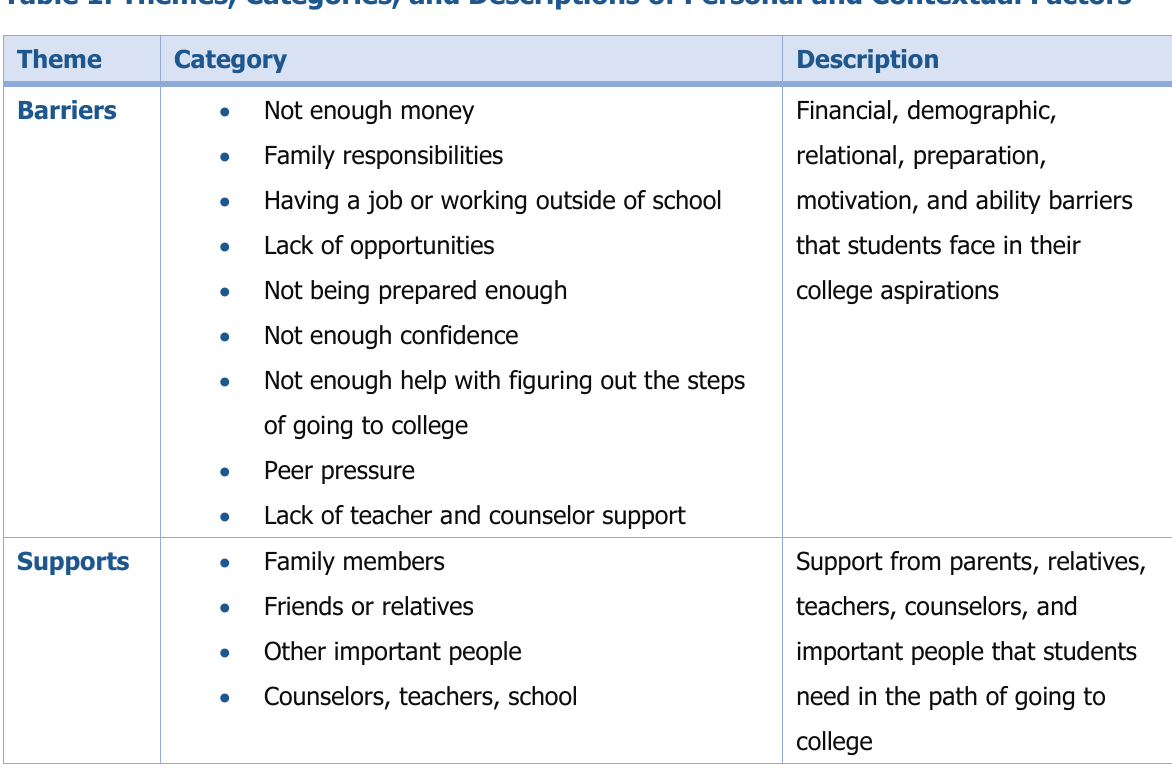
Table 1. Themes, Categories, and Descriptions of Personal and Contextual